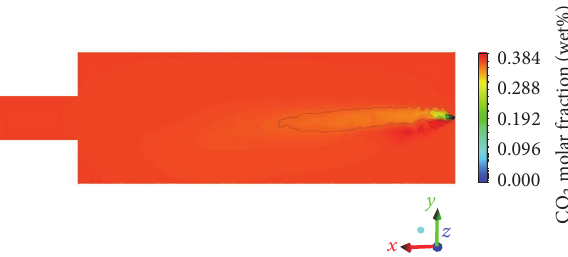
Figure 13: Distribution profile of volume percentage of CO 2 (wet basis) on the 𝑥 - 𝑦 plane in the middle of the